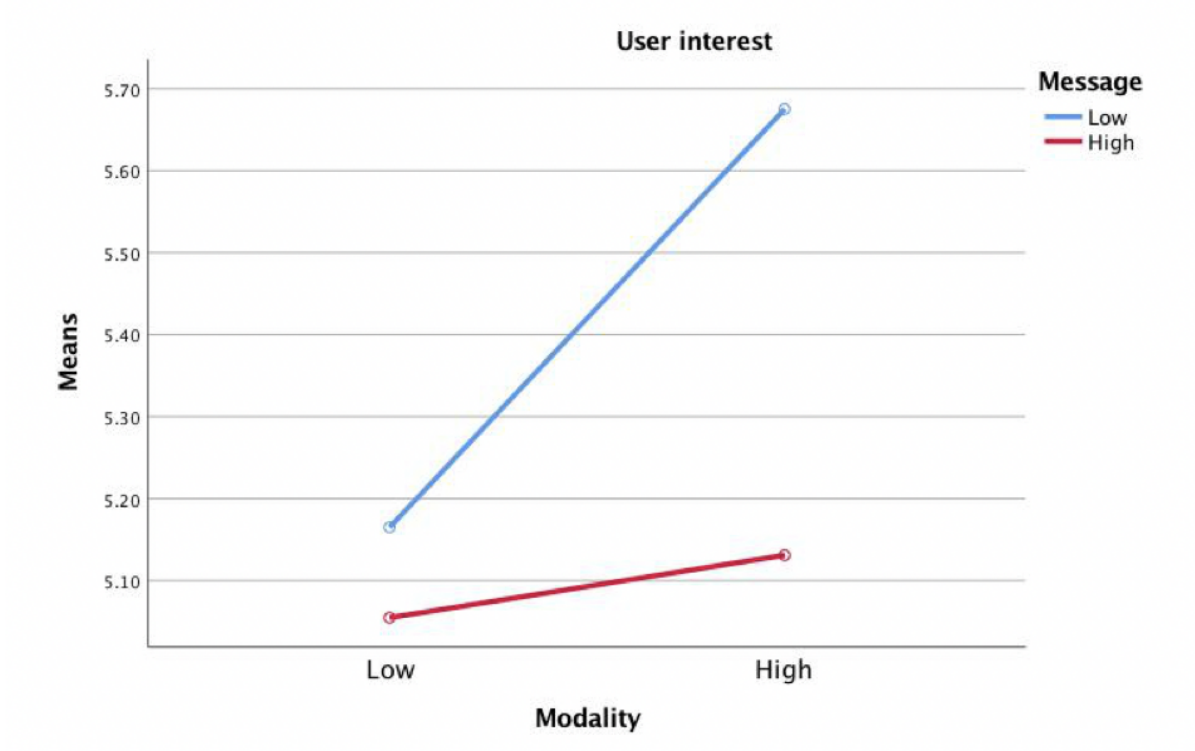
Figure 7. Modality interactivity and message interactivity effect on user